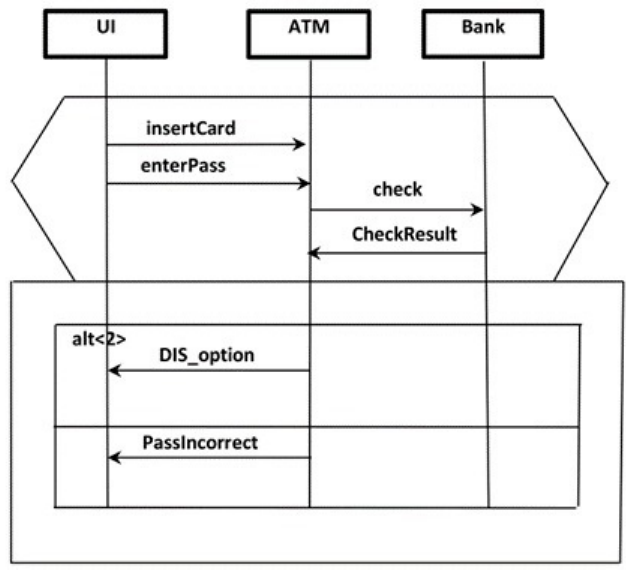
Figure 2. The password verification scenario of the ATM